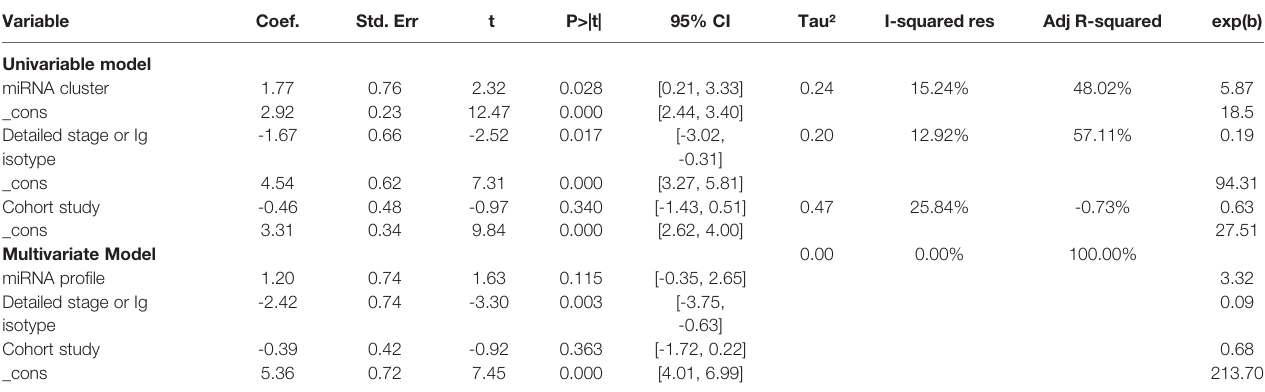
TABLE 3 | Meta-regression with univariable model and multivariate model. Variable Coef.